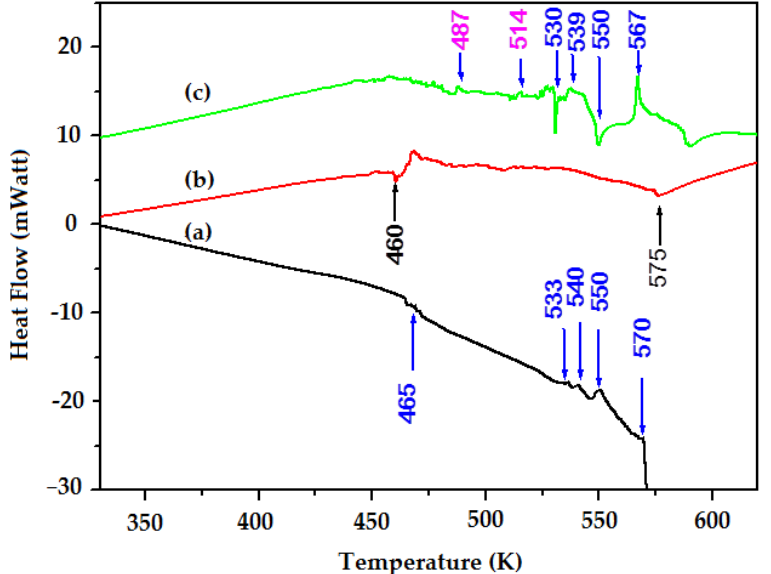
Figure 8. DSC thermograms of D-PANI ( a ), of SWCNTs ( b ) and of D-PANI/SWCNTs composite ( c ).